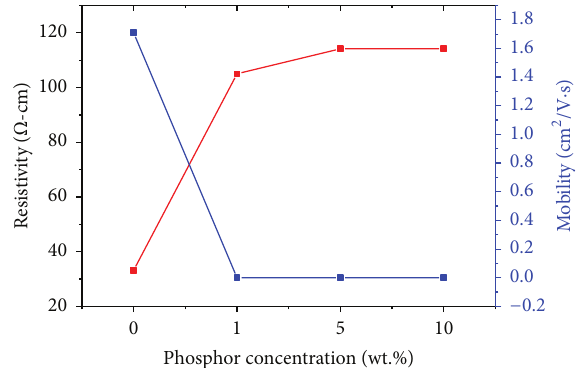
Figure 7: Resistivity and mobility of the ZnO thin films with different concentrations of incorporated YAG deposited on glass